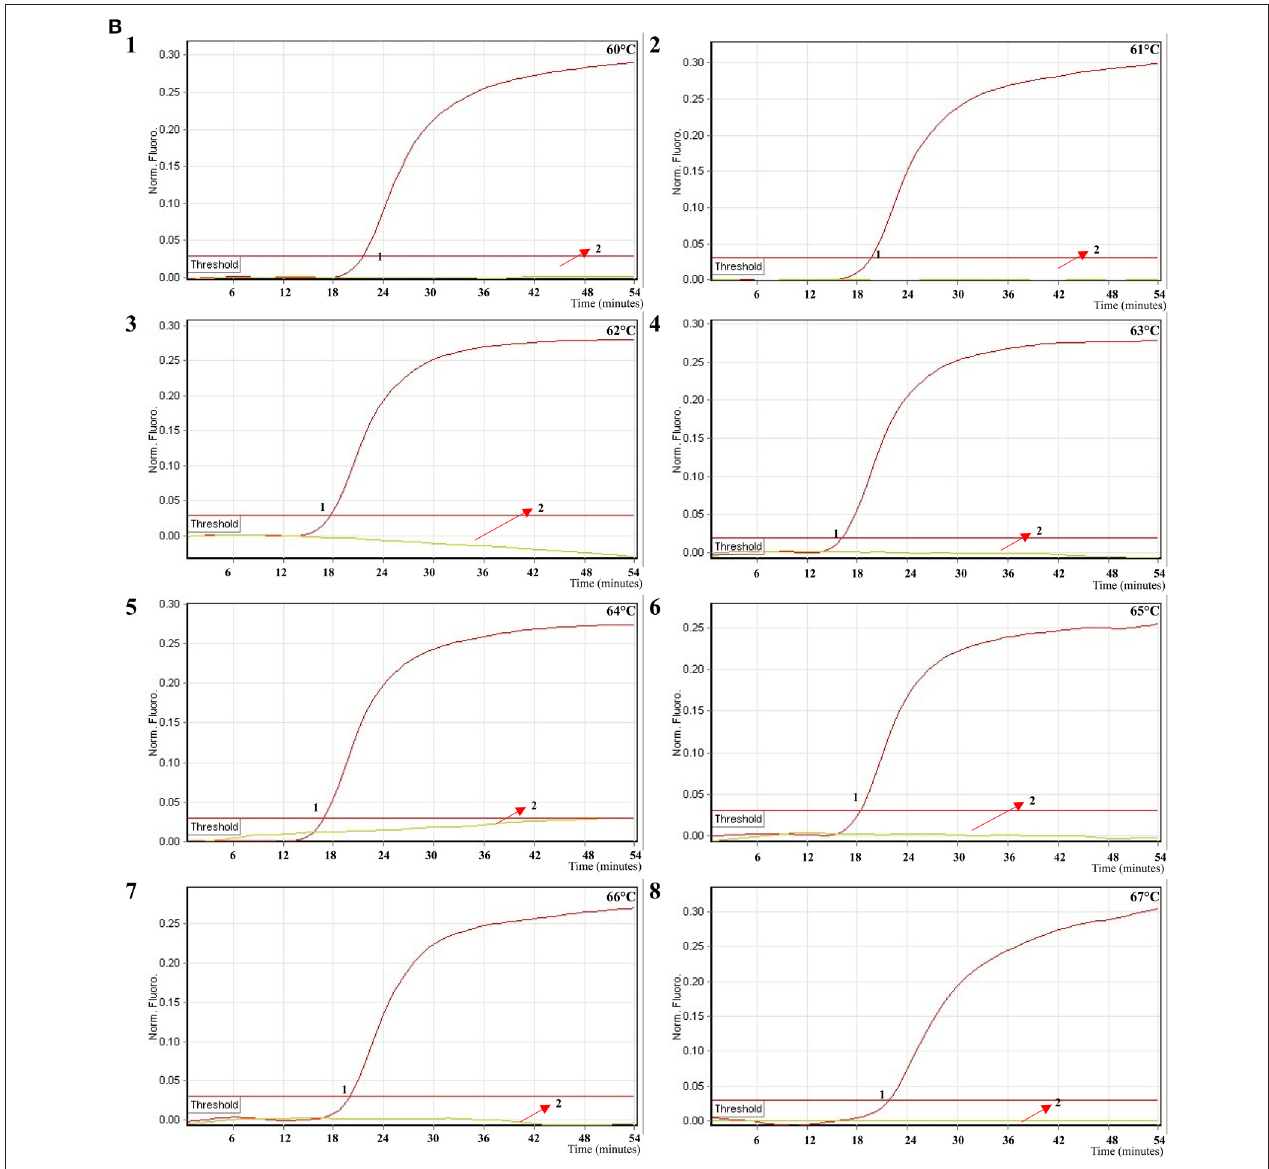
FIGURE 6 | The optimal temperature for multiplex MERT-LAMP assay. Two sets of MERT-LMAP primers targeting ipaH and invA genes were used in the same reaction tube, (A,B) were simultaneously obtained from Cy5 (labeling Shi -EFIP of ipaH ) and Hex (labeling Sal -EFIP of invA ) channels, respectively. The multiplex MERT-LAMP amplifications were detected by means of real-time format, and the corresponding curves of DNA concentrations were listed. Signal 1 indicates Shigella flexneri strains of in Cy5 channel (A) , Salmonella Enteritidis strain for Hex channel (B) , and signal 2 indicates negative control. Eight kinetic graphs (1–8) were generated at different amplification temperature (60 ◦ C–67 ◦ C) with Shigella genomic DNA at the level of 2.5ng in Cy5 channel (A) ; another eight kinetic graphs (1–8) were yielded at different detection temperature (60 ◦ C–67 ◦ C) with Salmonella genomic DNA at the level of 2.5ng in Hex channel (B) . The graphs from 62 ◦ C to 65 ◦ C show robust